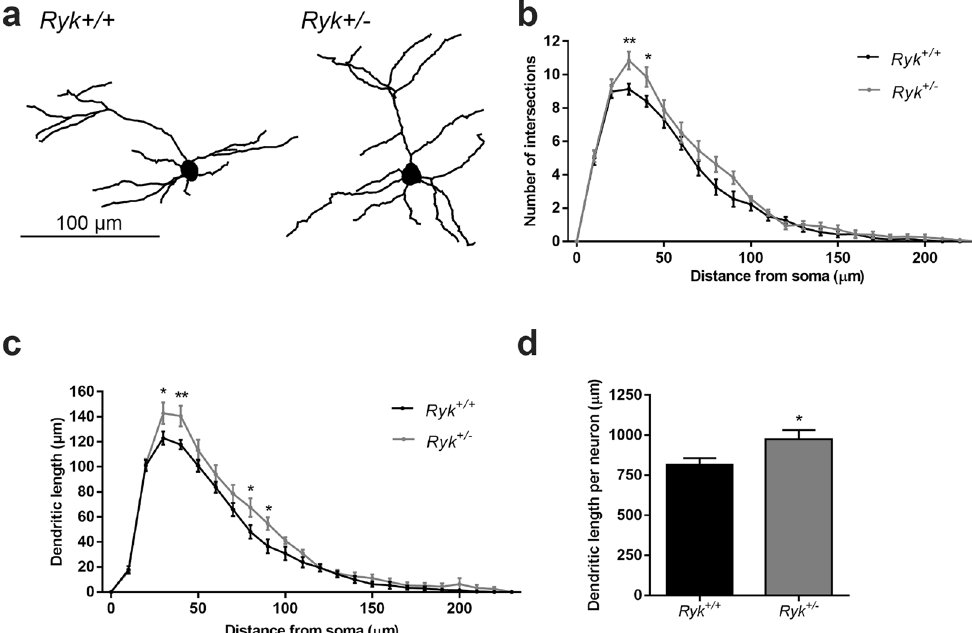
Figure 5. Ryk constrains layer 2/3 dendrite complexity in the somatosensory cortex. ( a ) Reconstruction of layer 2/3 pyramidal neurons in the somatosensory cortex of Ryk + / + (left) and Ryk + / − (right) P14 pups. ( b , c , d ) Sholl analysis of layer 2/3 neurons in the P14 Ryk + / − and Ryk + / + somatosensory cortex. ( b ) Compared to Ryk + / + neurons, there was a significant increase in the number of branches (number of intersections) within 50 μ m of the soma and a trend towards increased branching at greater distances in Ryk + / − neurons (13 Ryk + / + and 12 Ryk + / − animals; 4 neurons/animal; * p < 0.05; ** p < 0.01). ( c ) The aggregate dendrite length within each concentric radial segment was greater for Ryk + / − than for Ryk + / + neurons ( * p < 0.05; ** p < 0.01). ( d ) The mean total length of dendrites/neuron was greater for Ryk + / − neurons compared to Ryk + / + neurons ( * p = 0.0298). Data are represented as the mean ±